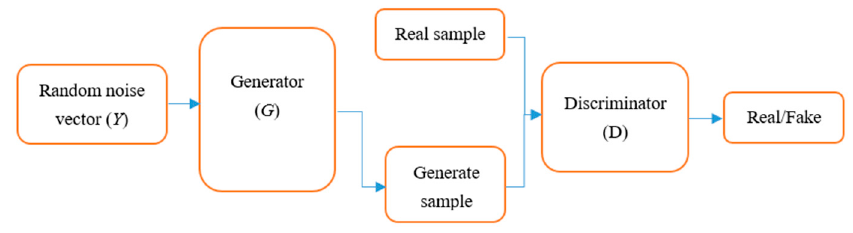
Figure 1. Simple structure of GAN.